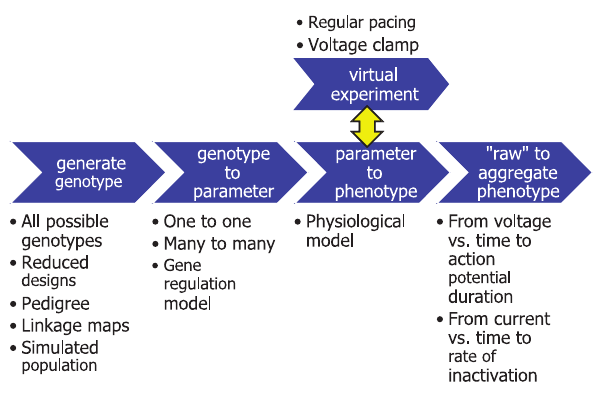
FIGURE 3 | Simulation pipeline for causally cohesive genotype–phenotype studies. Blue arrows denote functions that generate genotypes or transform them through successive mappings, genotype to parameter to “raw” phenotypes to aggregated phenotypes. The surrounding text exemplifies different alternatives for each piece of the pipeline, e.g., a simple mapping of variation at one locus to variation in one parameter, or a more mechanistic gene regulatory model. “Virtual experiments” interact with physiological models to generate phenotypes defined by the system’s response to external